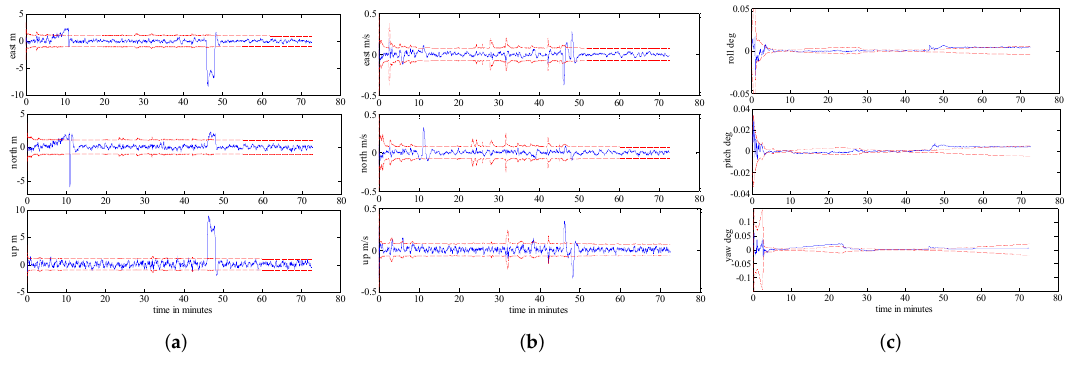
Figure 16. Error plots ( a ) Position error; ( b ) Velocity error; ( c ) Velocity